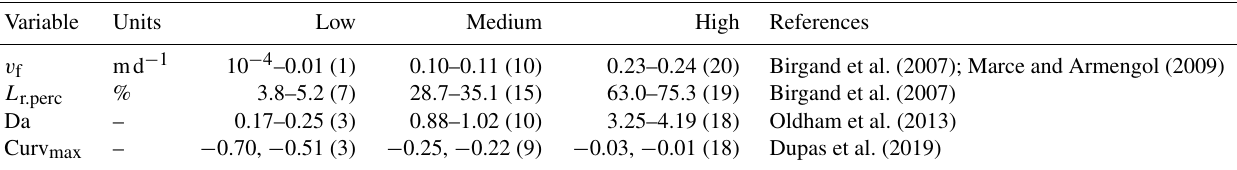
Table 3. Classes containing low, medium and high values for response variables v f (uptake velocity), L r.perc (percentage of load removed) and Da (Damköhler number) are used for the CART training and testing samples. Similar classes are obtained for model output Curv max . These classes stem from distributing the non-missing simulation data over 20 percentiles and selecting the percentiles corresponding to low, medium and high literature values, with the respective percentile number (1–20) indicated in brackets. This was done to ensure that for one variable, each class contains the same number of simulation data points. The training sample for constructing the CART model was then allocated 80% of this data and the test sample